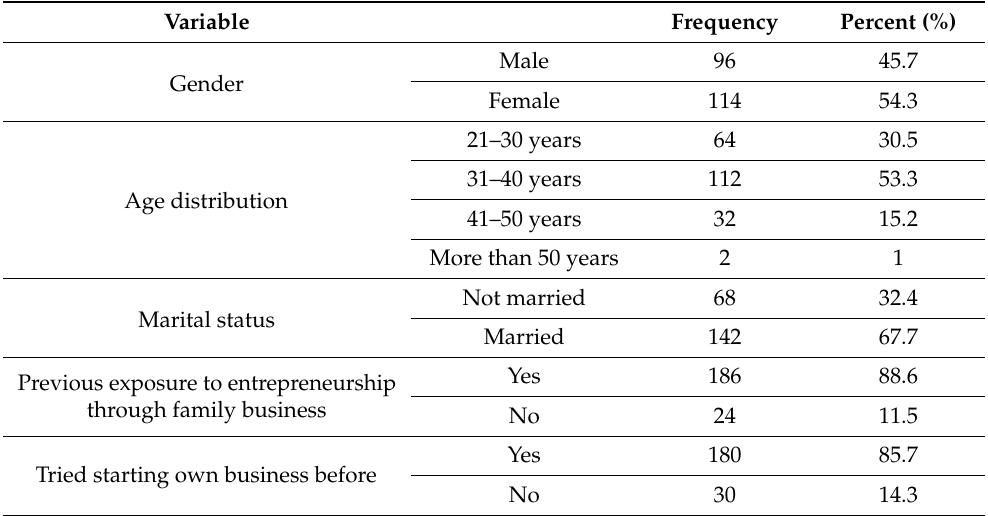
Table 1. Demographic profile of